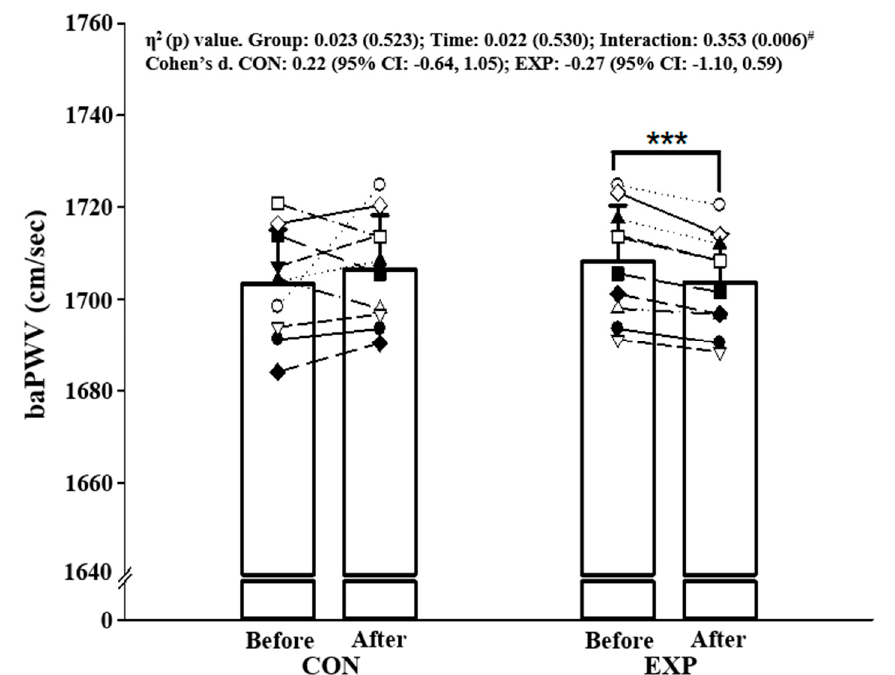
Figure 1. Changes in arterial stiffness before and after 12-week intervention: baPWV. Note. Values are expressed as mean ( ± standard deviation), CI = confidence interval, CON = control group, EXP = experimental group, each symbol ( □ ， △ ， ○ ， etc.) represents the individual participant's pre-test and post-test values, baPWV = brachial-ankle pulse wave velocity. # Significant interaction or main effect, *** p < 0.001 vs. before intervention.